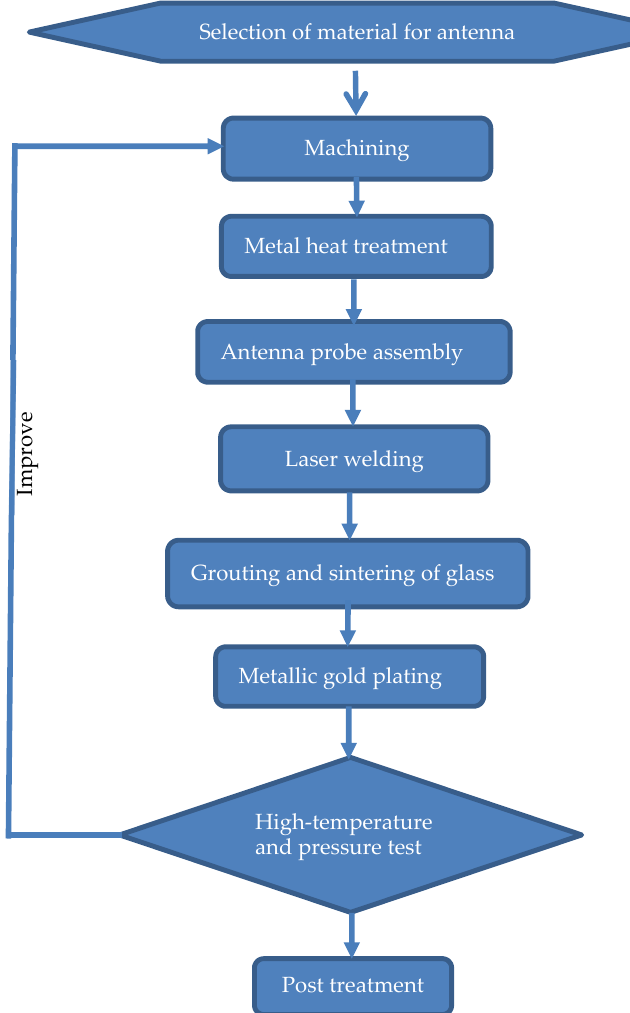
Figure 11. Workflow for development of a suitable antenna.